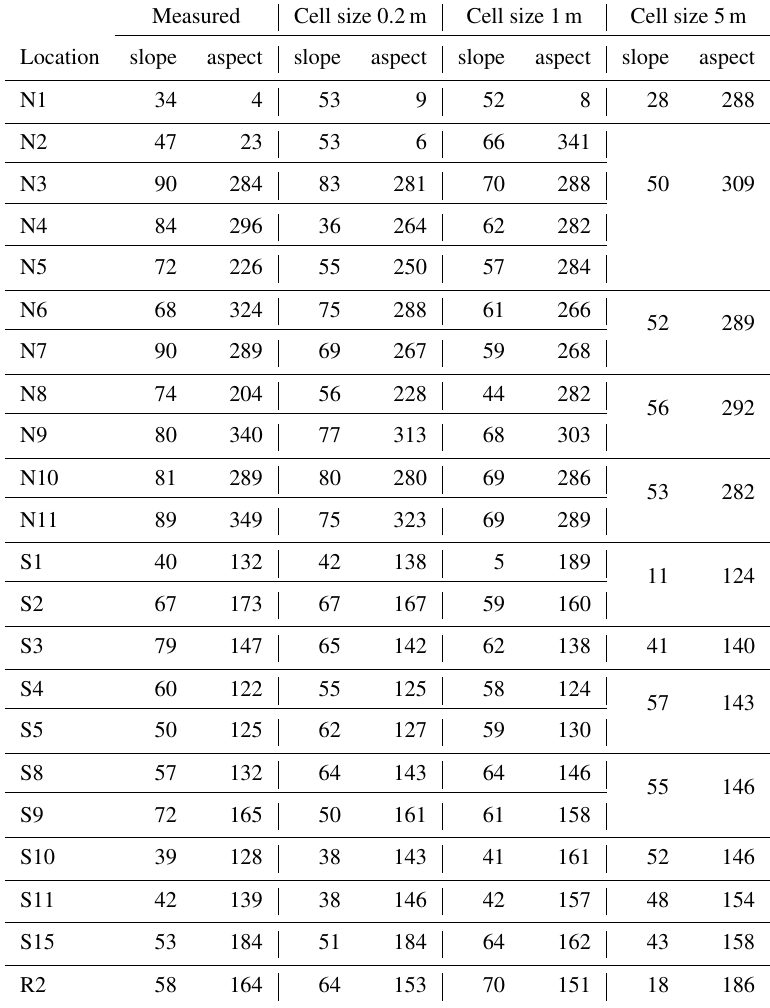
Table A1. Slope angle (slope) and aspect (both in ◦ ) measured at the 22 NSRT locations, as well as their topography in the model domain with varying grid cell